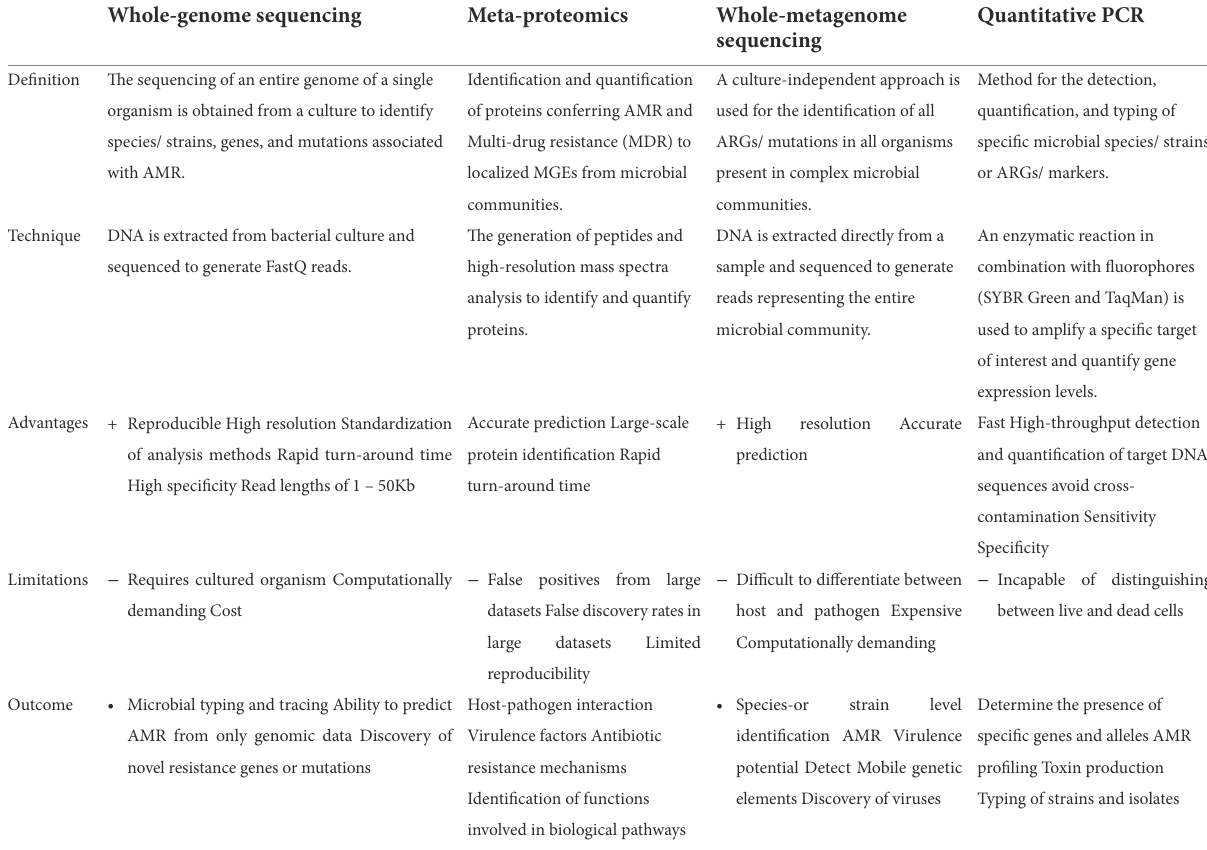
TABLE 2 Metagenomic sequencing vs. other techniques used to study qualitatively and quantitatively antibiotic